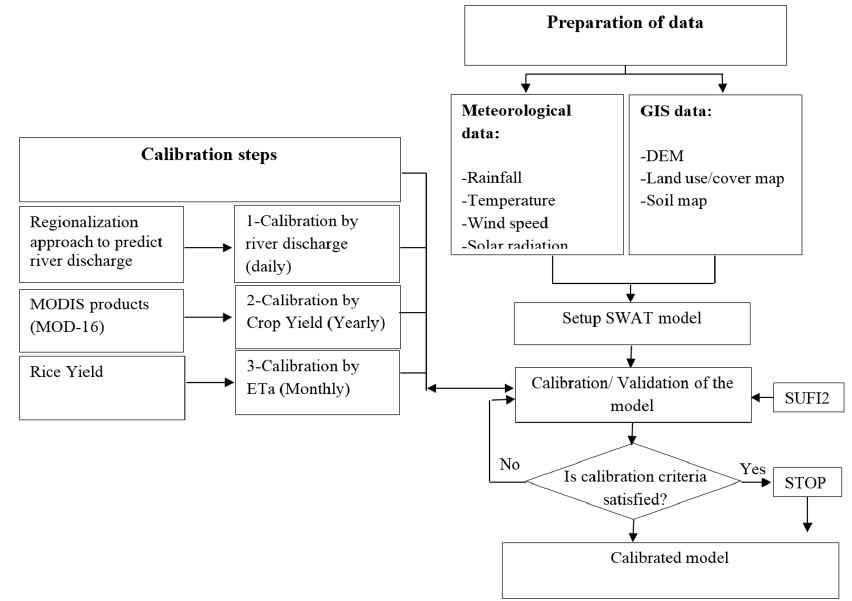
Figure 3. Flowchart of research, showing calibration procedure.